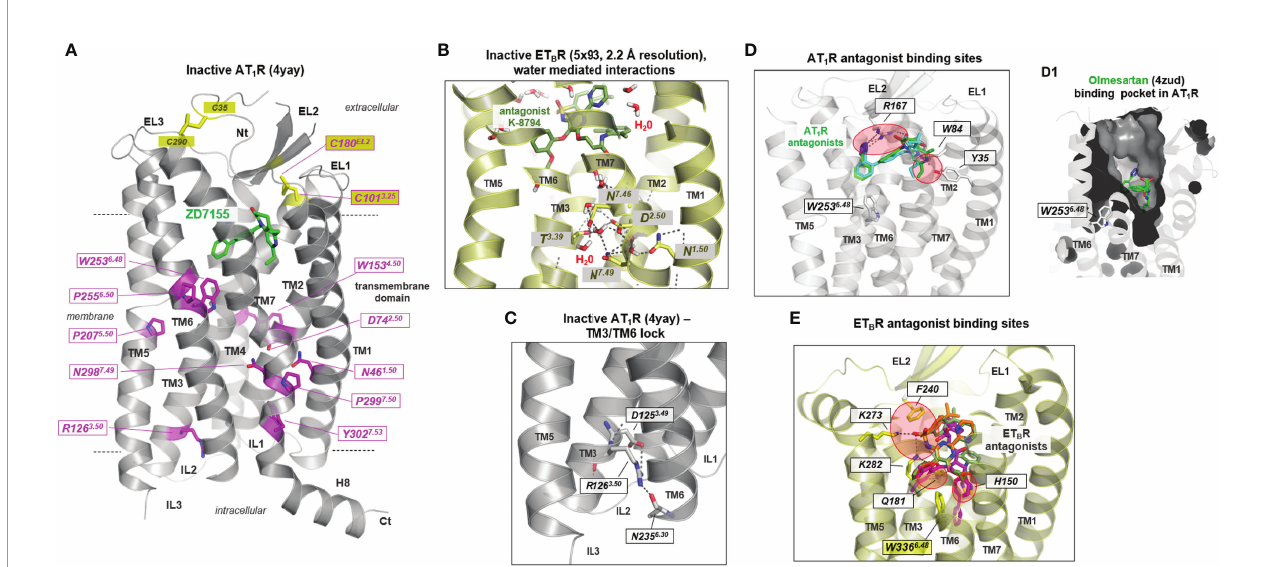
FIGURE 2 | Structural features of inactive or antagonized AT 1 R and ET B R conformations. (A) Conserved residues in class A GPCRs (magenta sticks) important for receptor-fold, expression, and signaling are highlighted at the inactive state structure of AT 1 R (backbone cartoon) in complex with the antagonist ZD7155 (green sticks). Highly signi fi cant for non-active state conformations is the inward direction of the transmembrane helix (TM) 6 into the helical bundle, which closes the intracellular binding cavity for G-proteins or arrestin (see also Figure 4E ). The antagonist ZD7155 (green) is bound in a pocket between the transmembrane helices and their transition to the extracellular loops. Notably, a disul fi de bridge (yellow sticks) between the N-terminus and the EL3-TM7 transition forms and stabilizes the spatial region between the N-terminus and EL3, which is also present in the AT 2 R and the ET B R (not shown). (B) In the antagonized ET B R structure bound with the antagonist K-8794, water molecules solved at a high resolution of 2.2 Å. These water molecules are located centrally in the helical bundle, participating by H-bonds with hydrophilic residues in maintaining an inactive state conformation. (C) Of the currently known fi ve inactive state structures for ETRs and ATRs, only one inactive state shows a H-bond between the intracellular parts of TM3 and TM6 involving the highly conserved R 3.50 . In several class A GPCRs, an “ ionic lock ” between this arginine and a negatively charged amino acid in TM6 has been postulated or shown to be essential for constraining the inactive state (72, 73). This cannot be perceived equally for most of the available inactive ET B R and AT 1 R structures. (D) AT 1 R antagonists olmesartan (inverse agonist, cyan sticks) and ZD7155 (green sticks, Table 1 ) are bound mainly between three residues in EL2, TM1, and TM2 in the upper part of the helical bundle (PDB IDs: 4zud and 4yay). Red circles indicate the main contact points. (D1) Visualized is the binding pocket of olmesartan by a clipped inner surface representation. (E) Superimposition of ET B R structures (PDB IDs: 6k1q, 5x93, 5xpr - only one backbone structure is visualized as cartoon because of high overlap between these structures) with antagonists K-8794 (green), bosentan (orange), and IRL2500 (inverse agonist, magenta) shows partially largely binding regions in the receptors, but also signi fi cant differences to antagonist binding sites of AT 1 R (red circles). While a residue of the N-terminal EL2 is involved in ligand binding in both receptors, several H-bonds to amino acids in TM3 and TM5 can be observed in the ET B R. The inverse agonist IRL2500 additionally contacts (blocks) the highly conserved tryptophan in TM6 (W336 in ET B R), which is part of the CWxP 6.50 motif that participates in the activation mechanism of class A GPCRs. Red circles indicate the main contact points. All graphic representations in this article were created using the PyMol Molecular Graphics System Version 1.5 (Schrödinger, LLC, New York, NY). EL, extracellular loop; Nt, N terminus; IL, intracellular loop; H8, helix 8; TM1 – 7, transmembrane helices 1 –